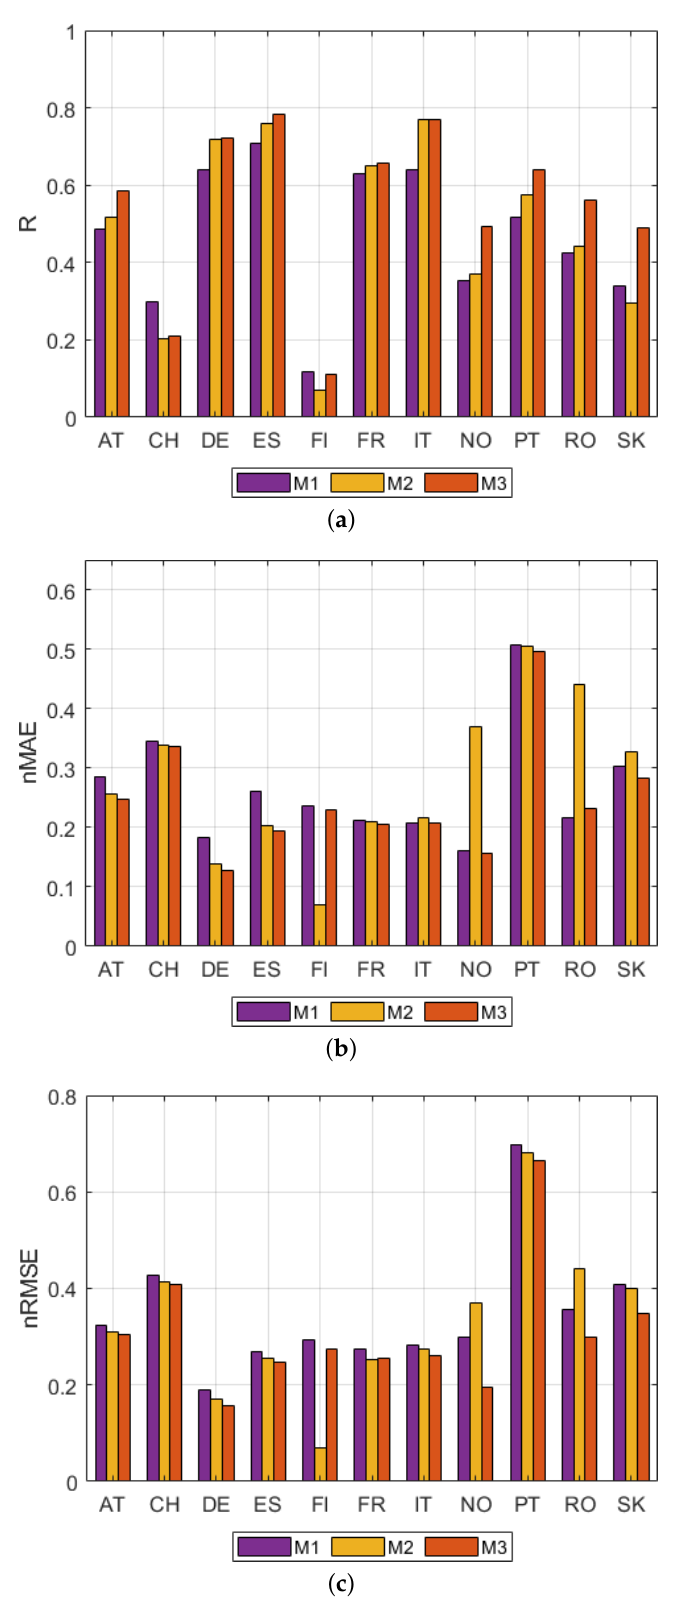
Figure 6. Models comparison via validation as in Table 3: ( a ) correlation coefficient, ( b ) normalized mean absolute error, and ( c ) normalized root mean square